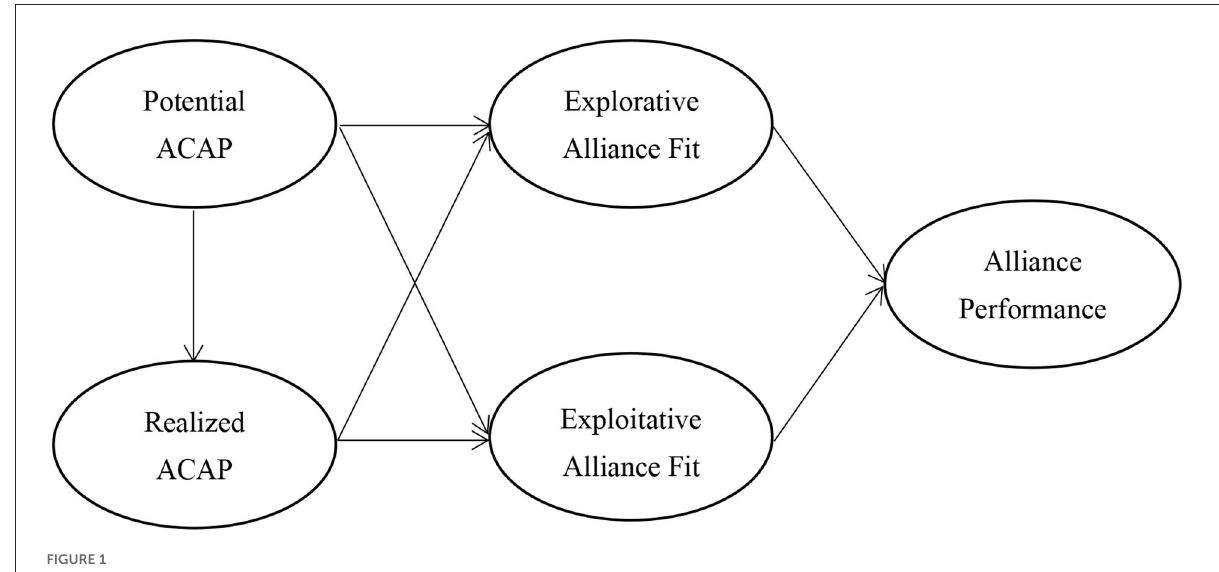
FIGURE1 Research